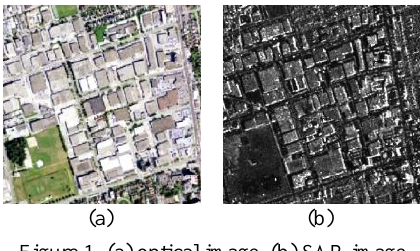
Figure 1. (a) optical image. (b) SAR